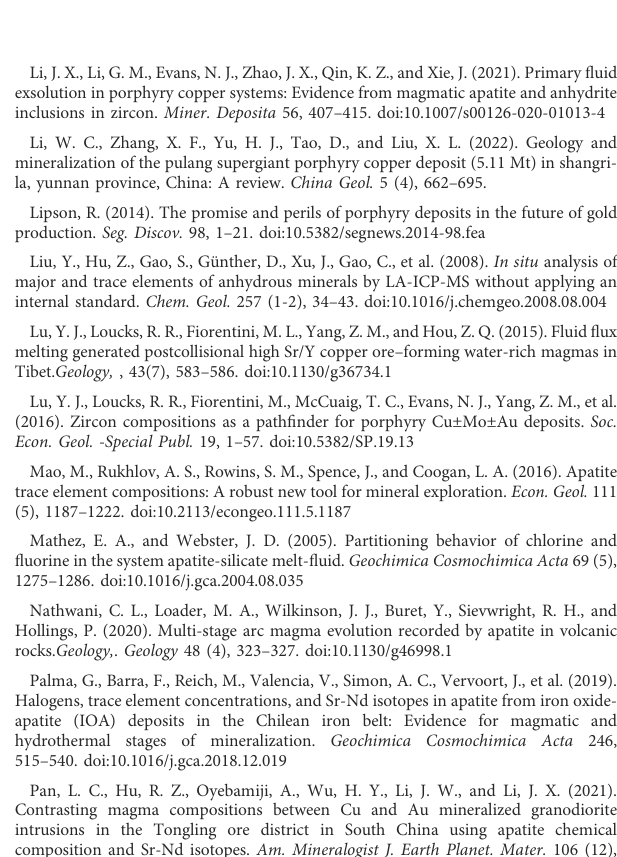
SUPPLEMENTARY TABLE S1 Apatite major and trace element compositions with calculated apatite Σ REE, Eu/Eu*, Ce/Ce*, and atoms per formula unit (apfu) values of the Kalmakyr porphyry Cu – Au deposit, Uzbekistan. SUPPLEMENTARY TABLE S2 Compiled apatite Eu/Eu*, Ce/Ce*, La/Yb, and Sr/Y ratios for ore-bearing and ore-barren intrusions of porphyry